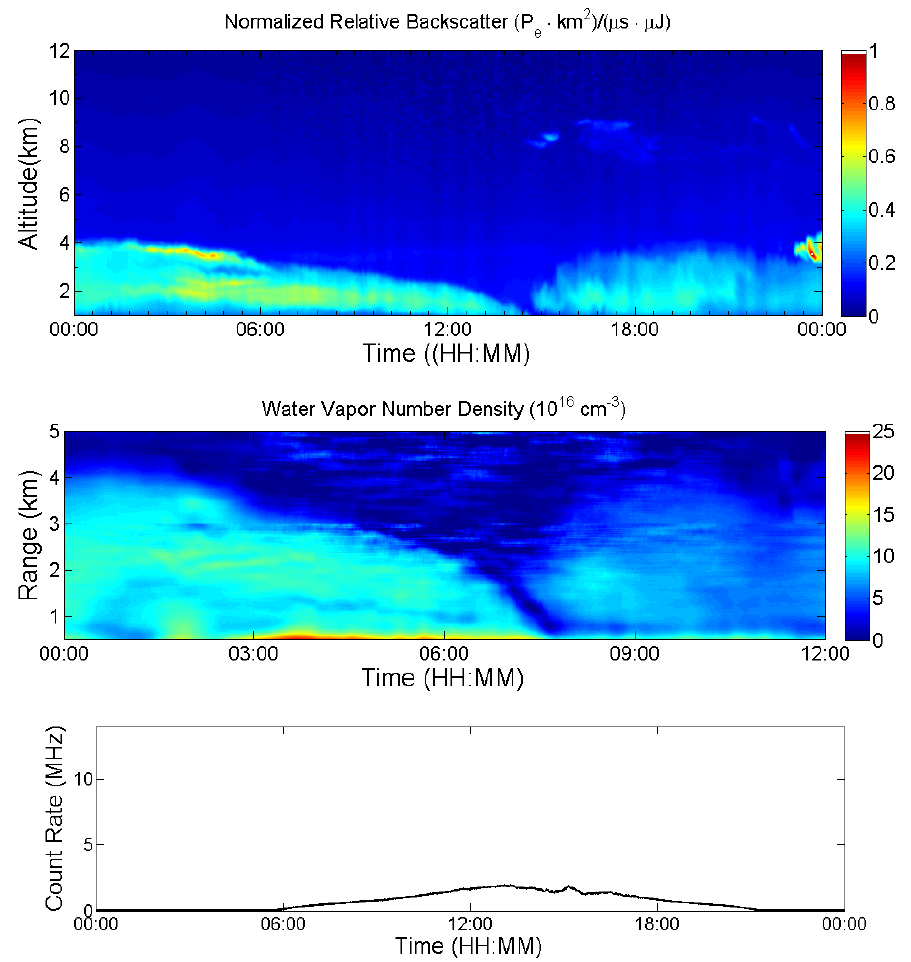
Figure 8. The upper plot shows the normalized relative backscatter as a function of time and range for 20 July 2013, while the middle figure shows the corresponding water vapor number density as a function of range and time. The bottom figure shows the background count rate as a function of time measured using the last fifty ranges bins. For clear sky operations, the maximum background count rate is less than 2 MHz and water vapor retrievals during daytime operations can be achieved between 4 and 6 km depending on atmospheric